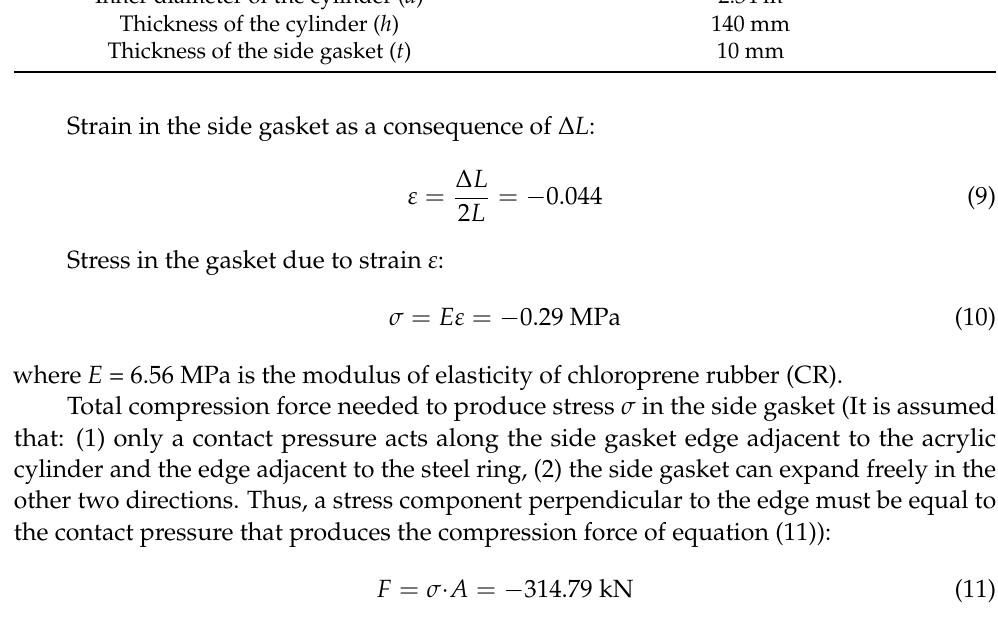
Table 2. Dimensions of a cylindrical hull section and the side gasket. Dimension Value Length of the cylinder ( L ) 2.4 m Inner diameter of the cylinder ( d ) Thickness of the cylinder ( h ) Thickness of the side gasket ( t